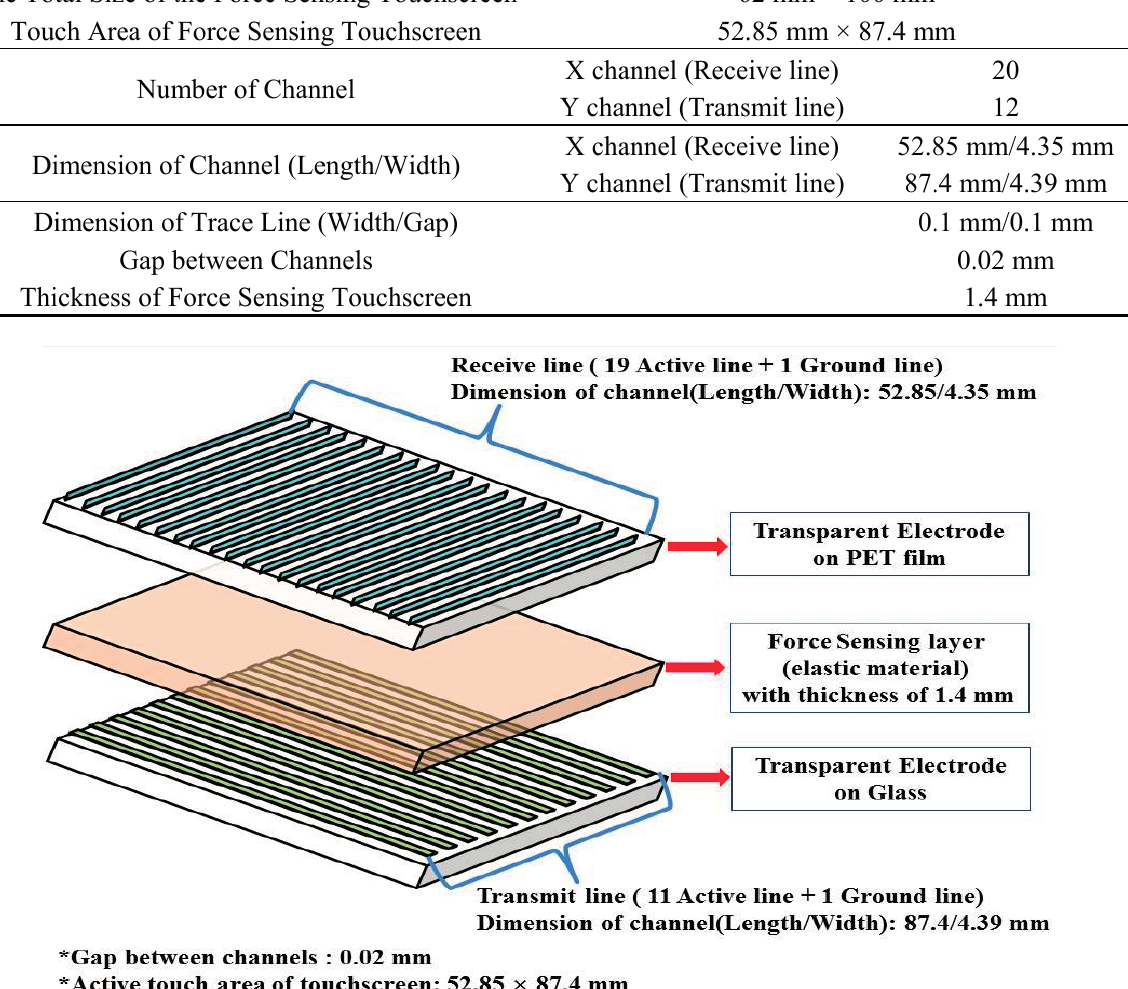
Figure 2. Schematic diagram of the force sensing touchscreen. Force sensing touchscreen is primarily composed of two patterned transparent electrode substrates and a force sensing layer with the property of elastic